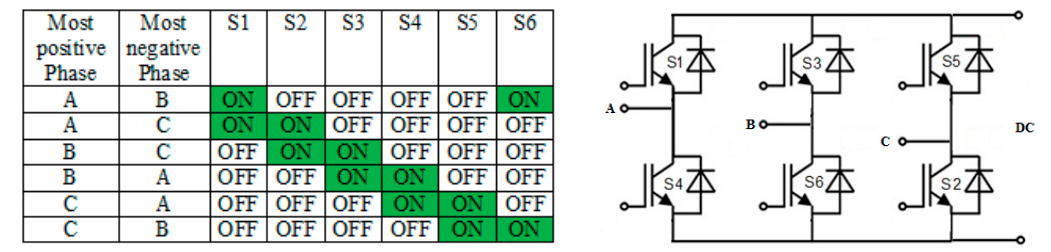
Figure 11. IGBT switching sequence for controlled rectifier operation.